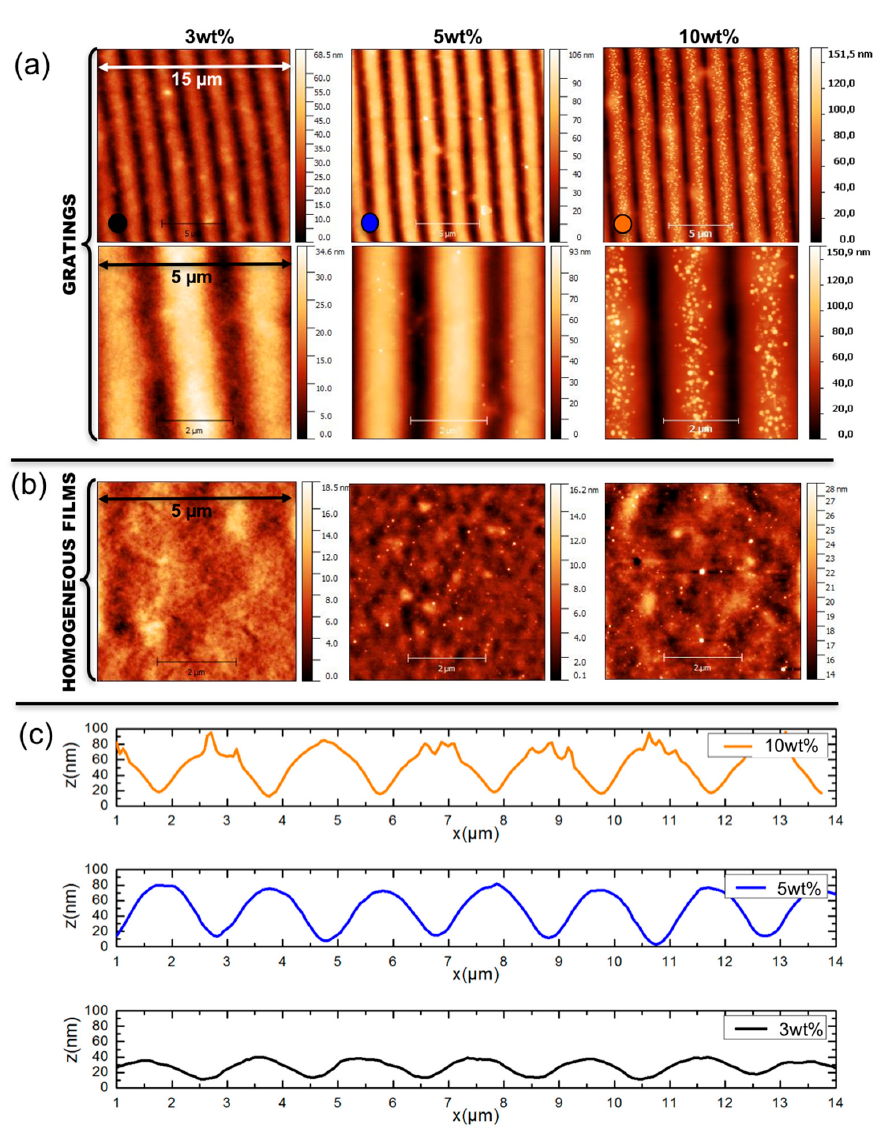
Figure 2. AFM images of the GNGs ( a ) and the HFs ( b ) with gold/polymer ratio of 3 wt %, 5 wt %, and 10 wt %. The surface profiles of the gratings are shown in ( c ).